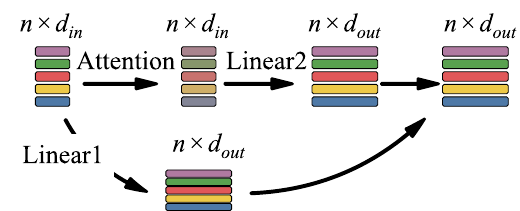
Fig. 13 A single deep set layer in the φ module